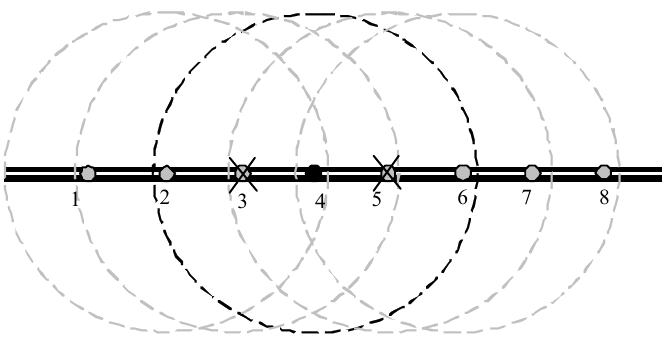
Figure 2. Reliability in dense sensor